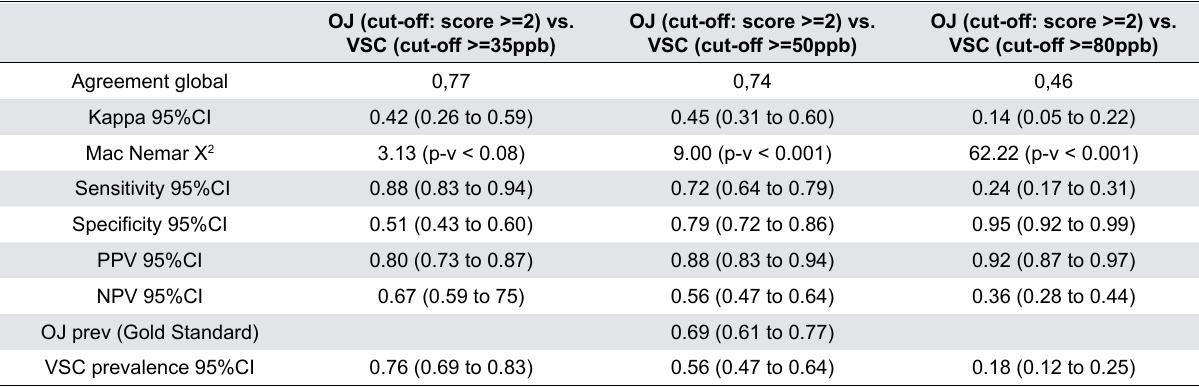
Table 5- Accuracy of volatile sulfur compounds (VSC) compared to organoleptic assessment by a trained professional (OA) at the sensitive cut-off point